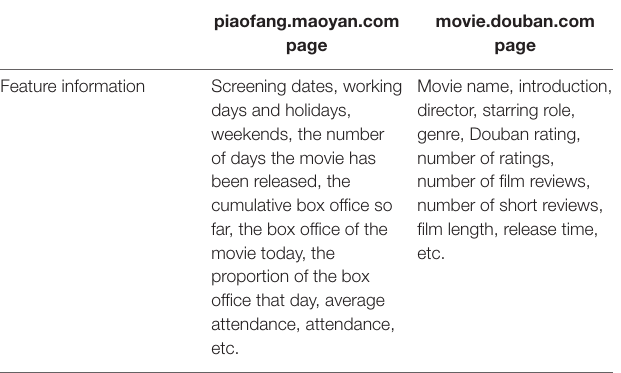
TABLE 1 | The selected feature information.